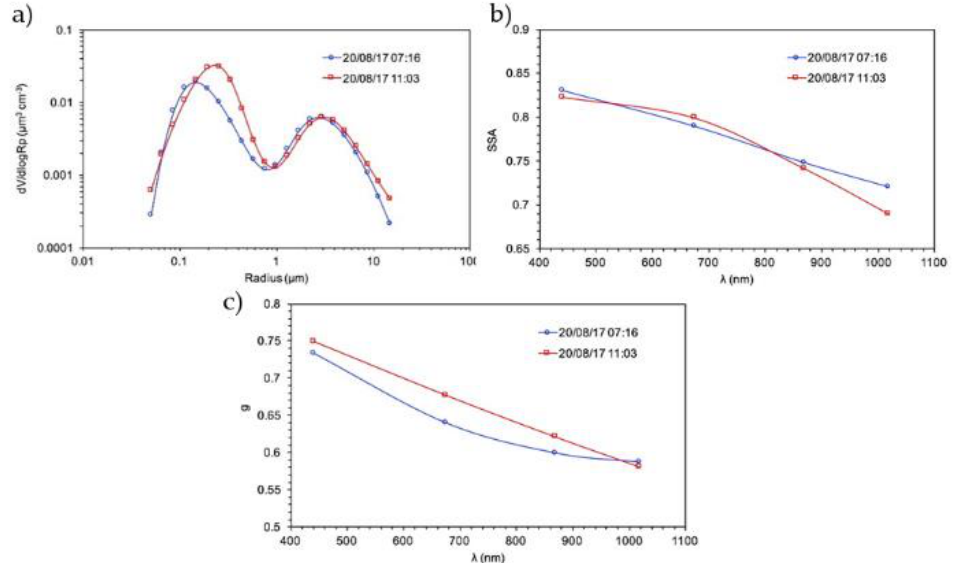
Atmosphere 2019 , 10 , x FOR PEER REVIEW 16 of 27